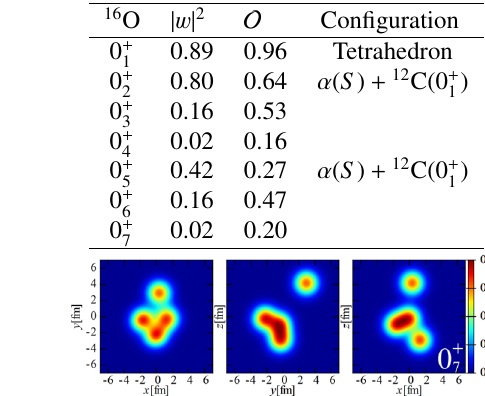
Table 1. α + 12 C(0 + ) components | w | 2 , the maximized 1 overlaps in Eq. (3) and the main components.